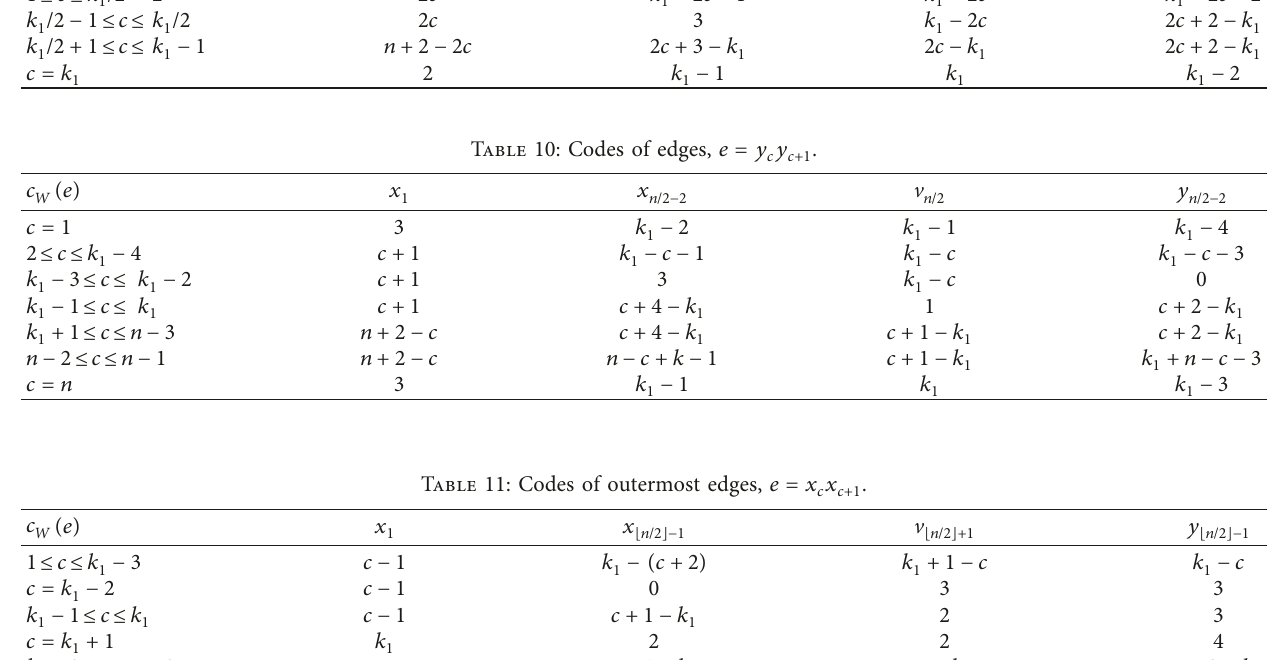
Table 9: Codes of edges, e � v